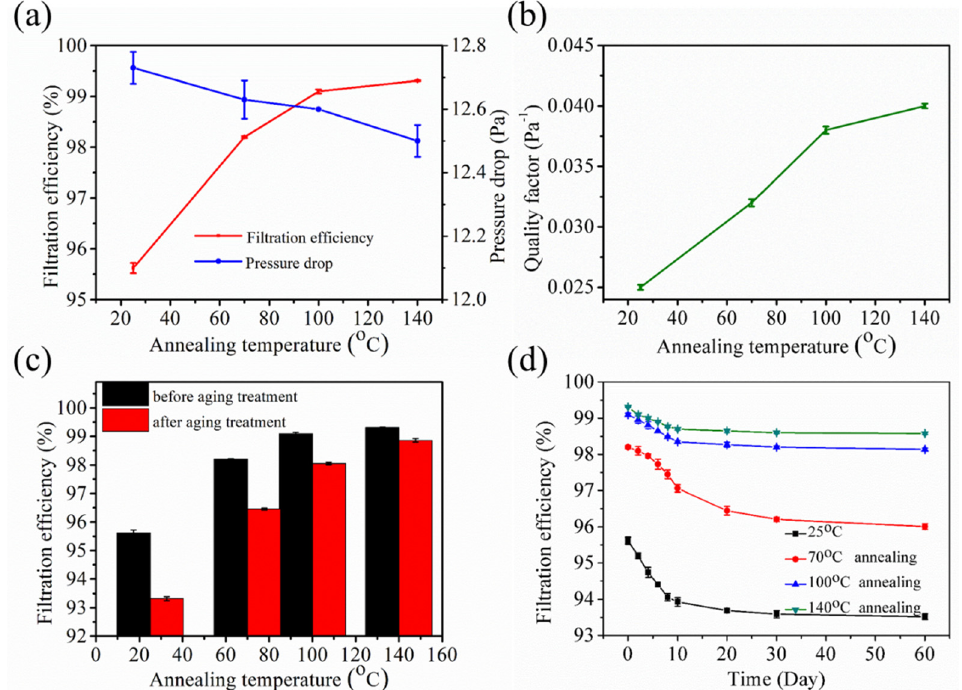
Figure 4. Filtration performances of the annealed melt blown samples: ( a ) filtration efficiency and pressure drop, ( b ) quality factor, ( c ) filtration efficiency decay after the aging treatment, and ( d ) filtration efficiency decay after two months .